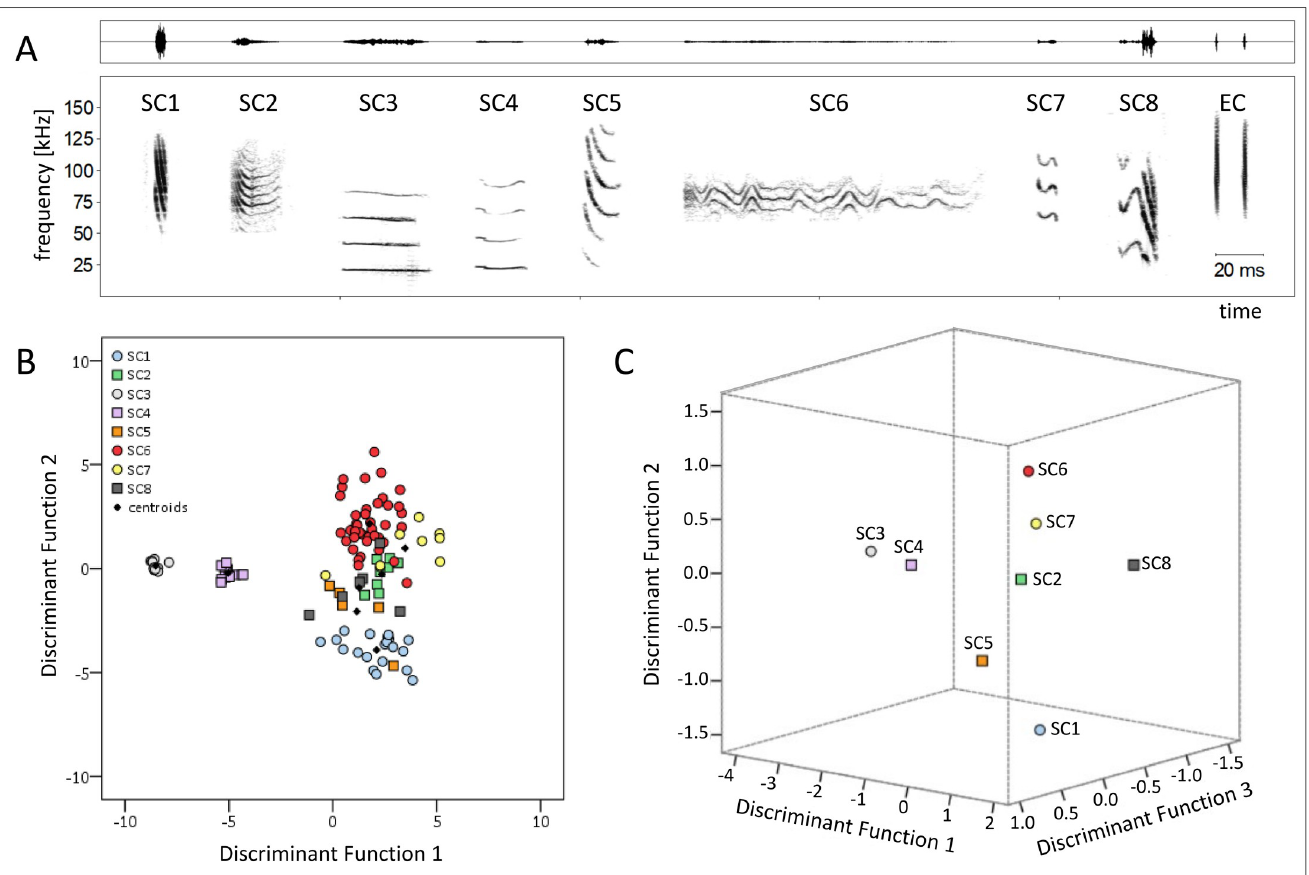
Fig 3. Eight social call types of E . alba . A: Spectrograms depicting eight social call types (SC1-SC8) and two echolocation calls (EC) of E . alba for comparative reasons. The spectrograms correspond to the natural appearance of those call types; i.e., suppression of the lower harmonics in types SC2, SC5, SC6, SC7. Social call types SC9 and SC10 are only depicted in the supporting information (S1 Fig in S1 File) as they are not included in acoustic and statistical analyses. Information about acoustic parameter measurements is given in Table 3. The context in which the social call types were emitted is described in Table 4. Spectrograms were created using a 1024-point FFT and a Hamming window with 87.5% overlap. B: The spacing of eight social call types of E . alba in a two-dimensional signal space defined by the two most important discriminant functions. Each social call type is represented by a distinct symbol, small black symbols represent centroids (i.e., the geometric centre of all calls per type in the DFA signal space). Note that EC are not included in the